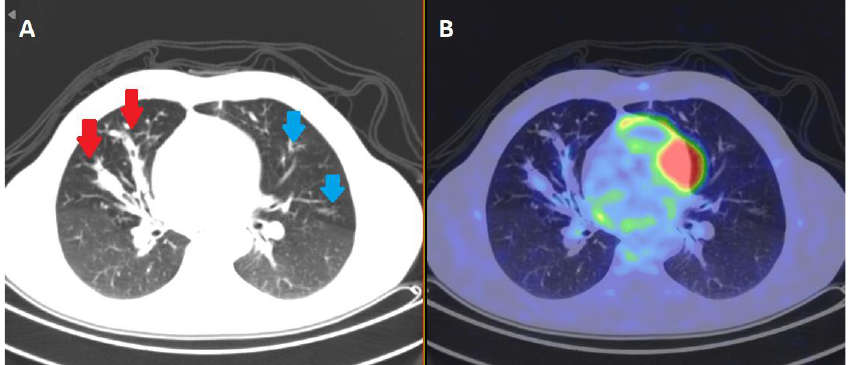
Figure 1. Sequalae of inflammation in CF. Various areas of inflammatory signal in the lung fields of a 40 year old male CF patient with relatively stable pseudomonal chest sepsis demonstrated on positive emission tomography (PET) body scan. Distal nodule opacities (blue arrows) and gas trapping distal to this are appreciated on the computerized tomography (CT) slice in box ( A ). The red arrows reflect bronchiectatic changes in the middle airways. In box ( B ), a positron emission tomography (PET) slice shows areas of F-fluorodeoxyglucose (FDG) tracer avidity in the corresponding areas of bronchiectasis, reflecting the infective/inflammatory nature of the lungs. Source: Alfred Hospital, Melbourne, VIC, Australia.